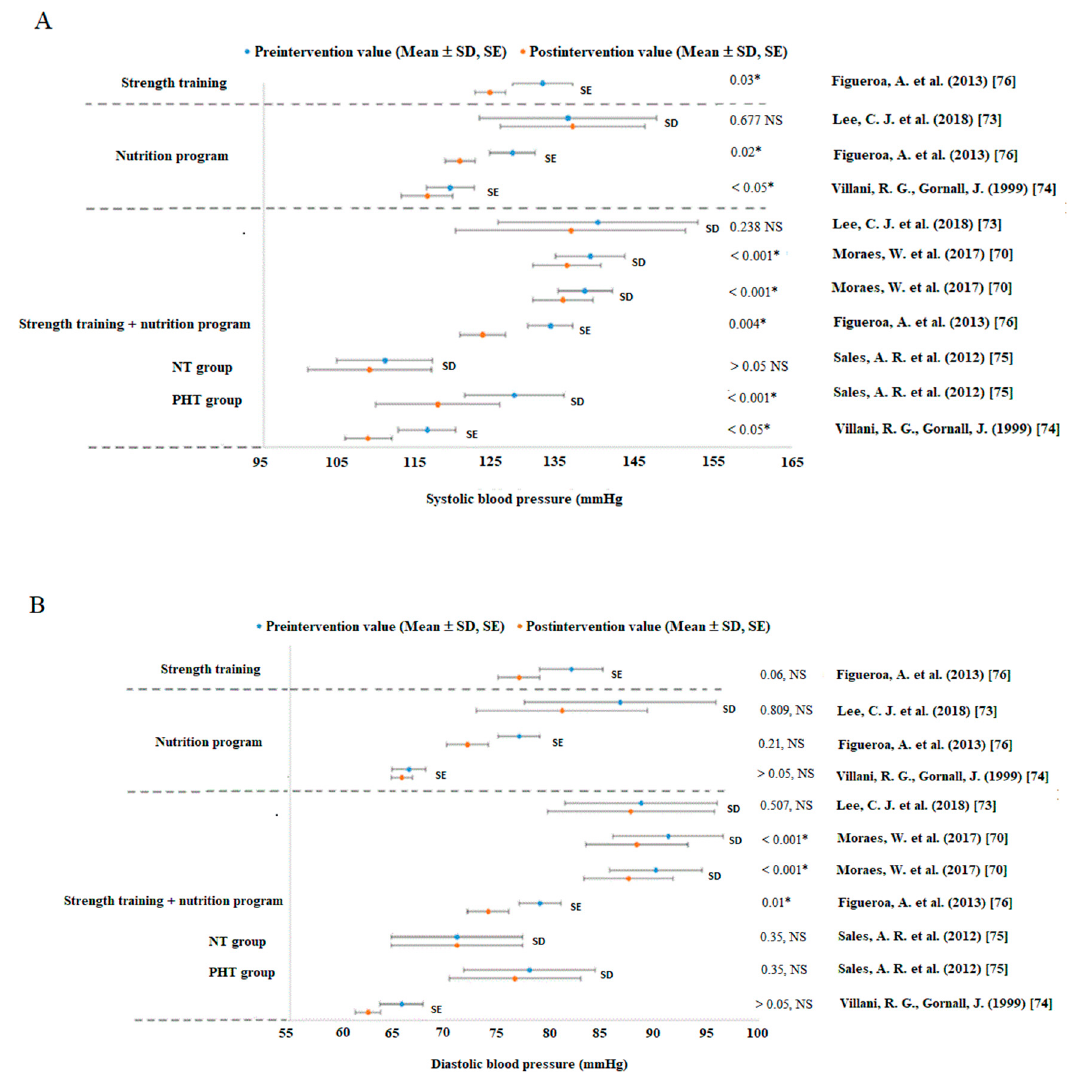
Figure 2. Changes in systolic ( A ) and diastolic ( B ) blood pressure (mmHg) in nutrition and strength training program studies. Abbreviations: NP = nutrition program, NT = normotension group, PHT = prehypertension group, SD = standard deviation, SE = standard error, ST = strength training, NS = not significant change—no change; * significant difference on reported p value.